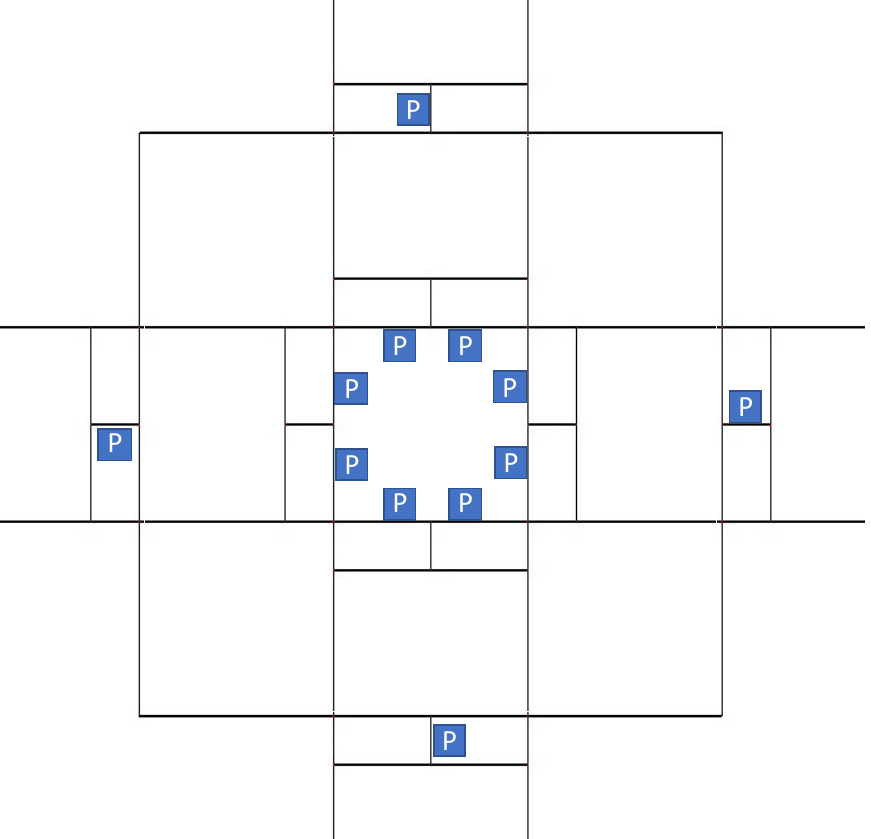
Figure 1. Schematic road network used in the experiments: black lines are roads, blue rectangles are parking spaces, and the grey area represents the city centre, i.e., the control zone for prioritization. We ran two simulations with different vehicle arrival rates. One simulation of 5 h with a fixed rate of 1000 vehicles per hour (generated with an exponential distribution) and another simulation of 5 h with varying arrival rates (1000 vehicles per hour during the first 2 h, 2000 vehicles in the third, 3000 vehicles in the fourth and 2000 vehicles in the fifth